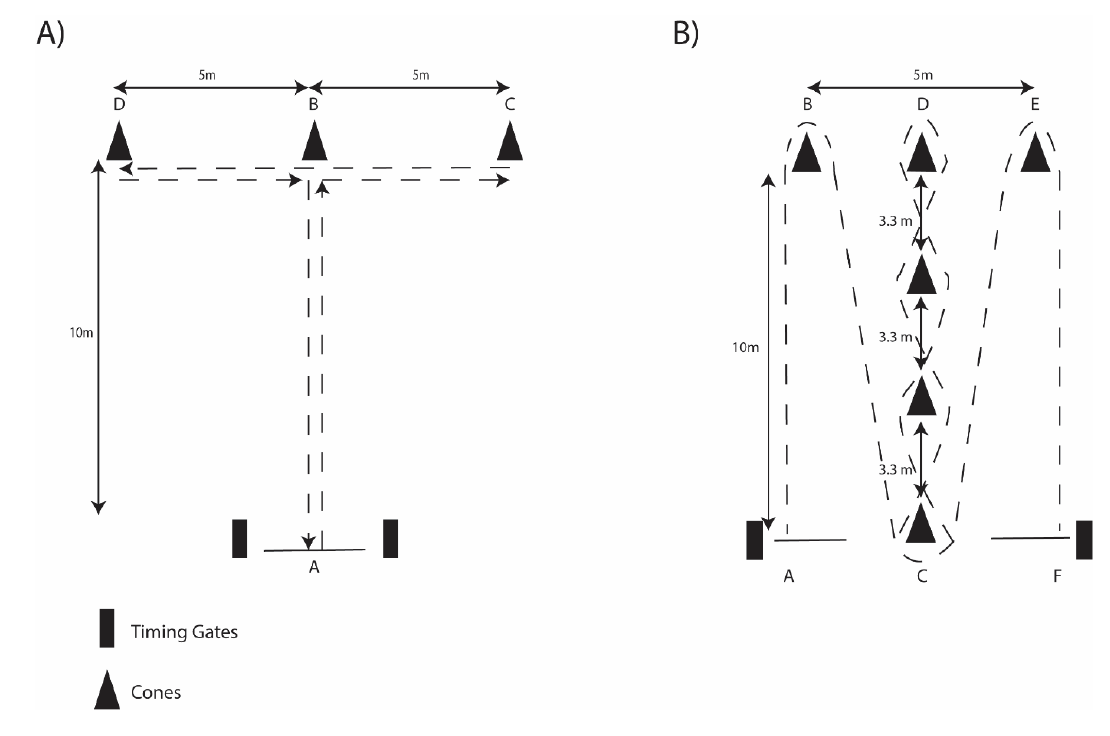
Figure 2. Schematic of A ) T-Test Agility and B ) Illinois Agility protocols.